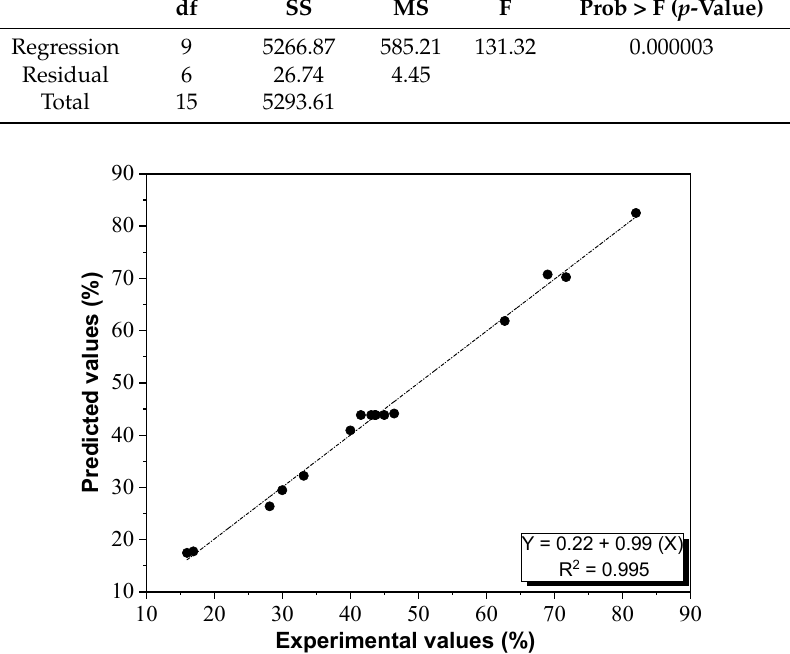
Figure 3. Linear correlation between the experimental and the predicted values of NAP removal efficiency. Table 5. p -test significance of model terms in the quadratic polynomial model.